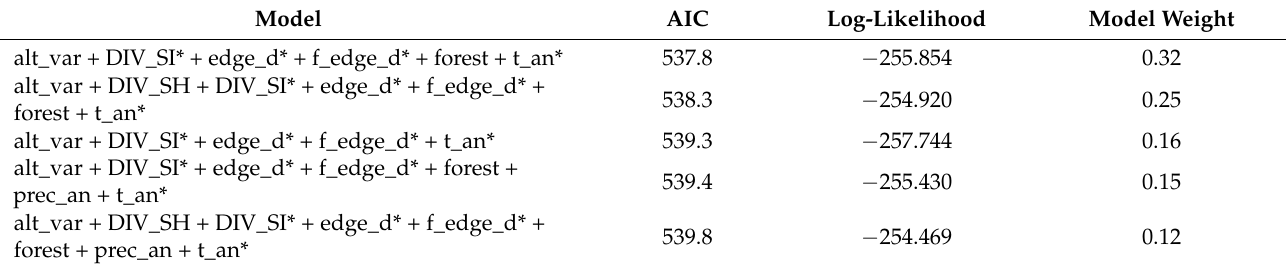
Table 2. Results of the model selection for the observed breeding pairs of Common Buzzards during the breeding season (2011–2012), in eastern Romania. Models were fitted as GLMMs, with surveyed squares and breeding seasons as random factors (intercepts). Five models constituting a 95% confidence set are presented, with Akaike Information Criterion (AIC), model log-likelihood, and relative model weight provided for each